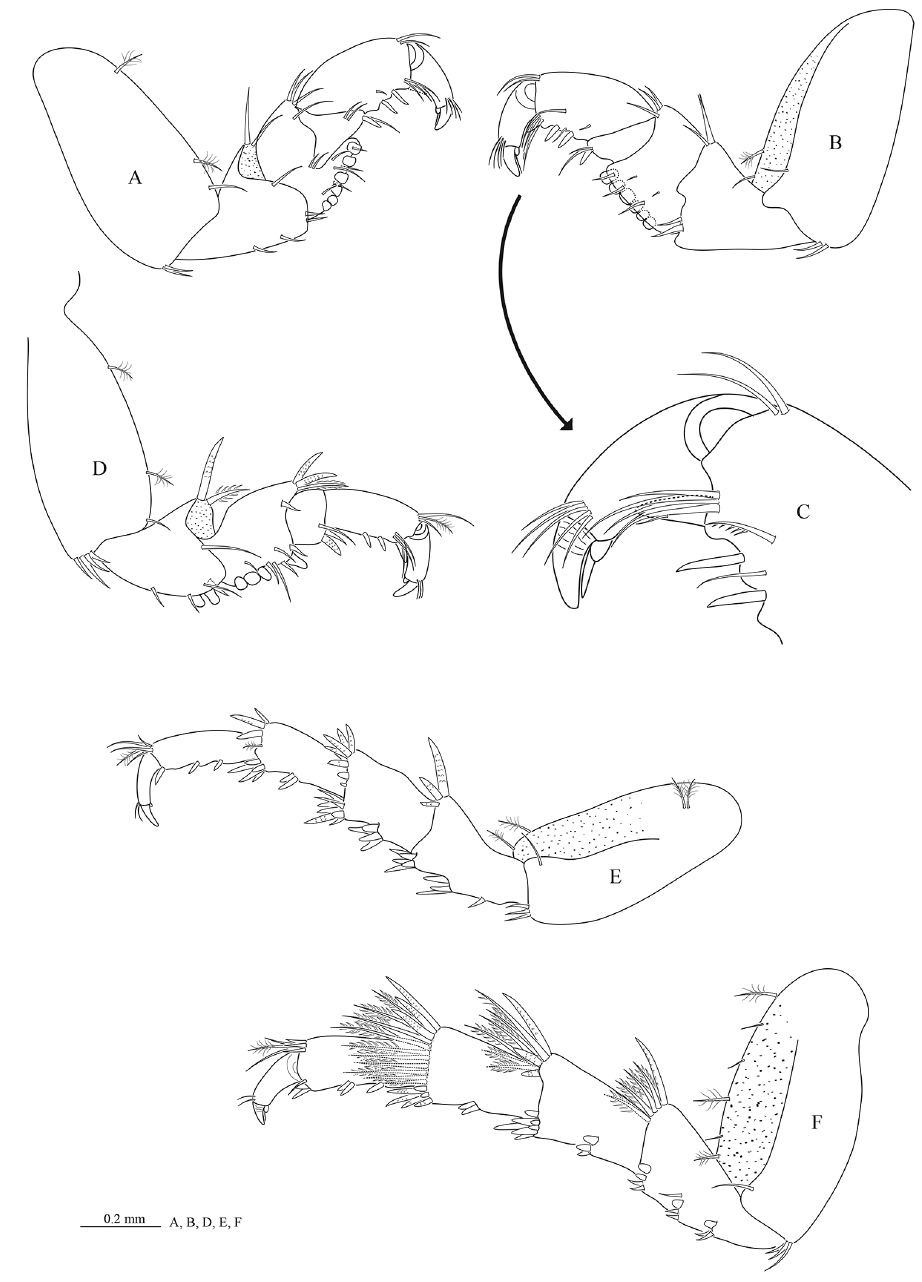
Figure 4. Cirolana phuketensis sp. n., male paratype (PSUZC–CR0286-02) (5.1 mm) A pereopod 1 B me- sial view of pereopod 1 C mesial view of dactylus of pereopod 1 D pereopod 2 E pereopod 4 F pereopod